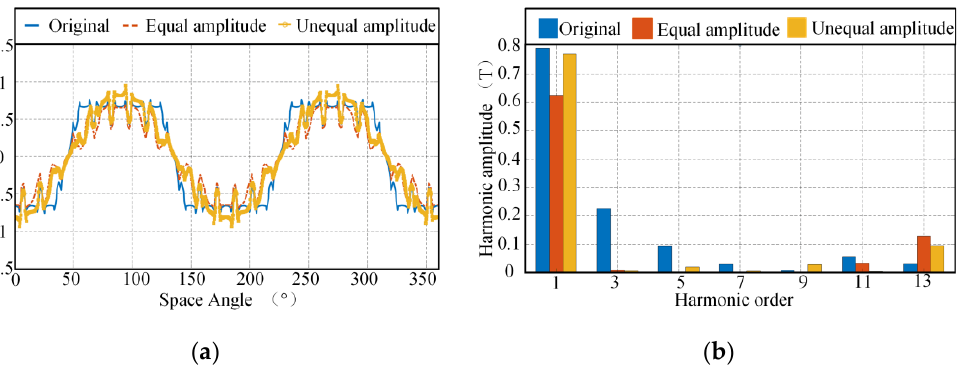
Figure 6. The comparison of no-load air-gap flux density of bearingless PMSMs with three kinds of magnetic pole structures. ( a ) No − load air-gap flux density; ( b ) Harmonic decomposition comparison chart.